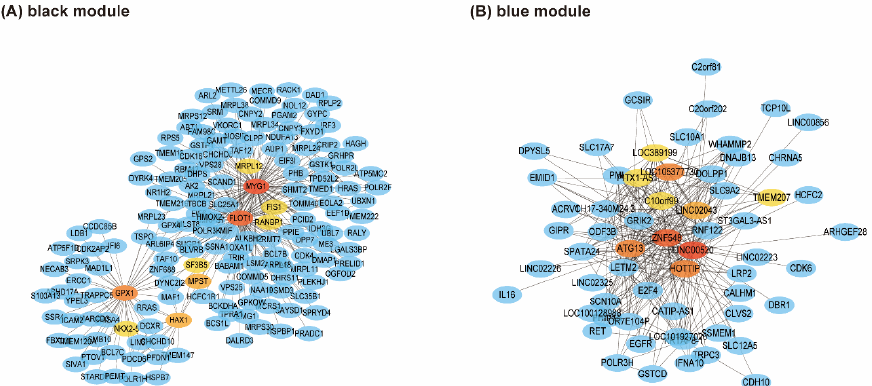
Figure 7. Key modules that contain hub genes of the PPI network. Hub genes are shown in different colors (the darker the gene, the higher the score). ( A ) PPI network for black module. ( B ) PPI network for blue module. MYG1 (degree = 104), FLOT1 (degree = 104), GPX1 (degree = 47), LINC00520 (degree = 59), ZNF548 (degree = 52), and ATG13 (degree = 36) were selected as hub genes.